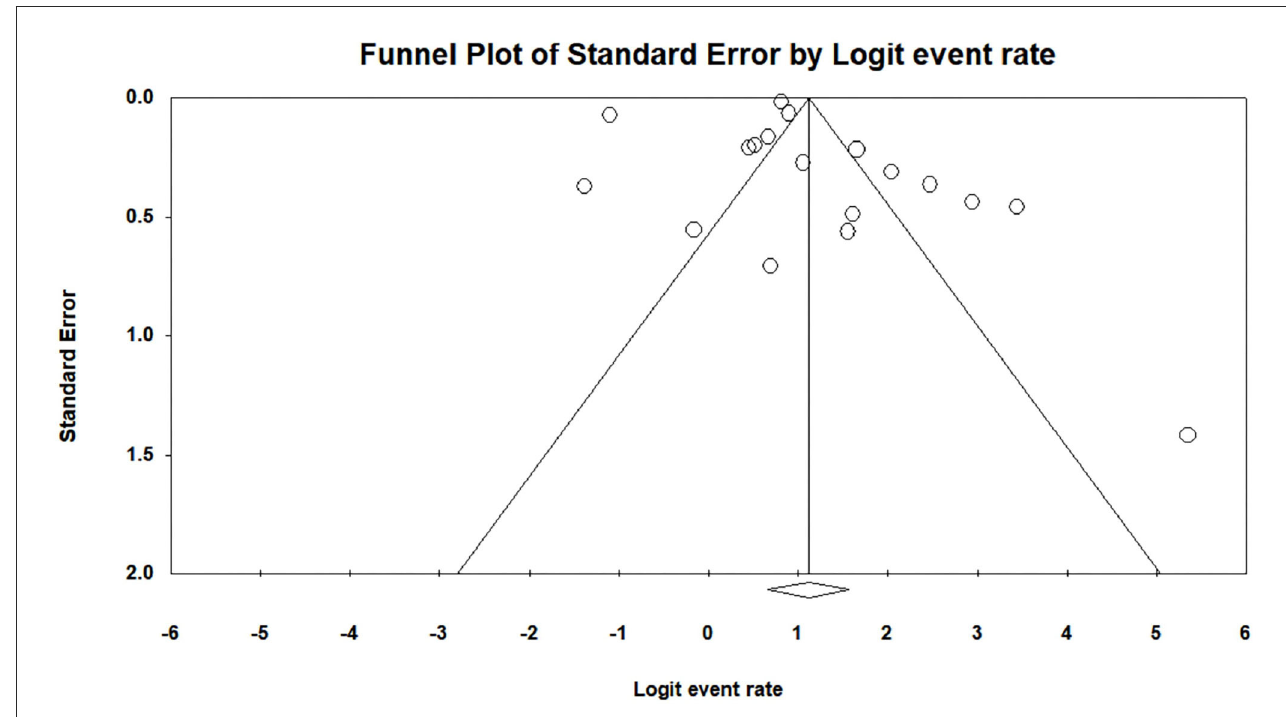
FIGURE3 A funnel plot assessing publication bias of satisfaction with online education among faculty before and after the COVID-19